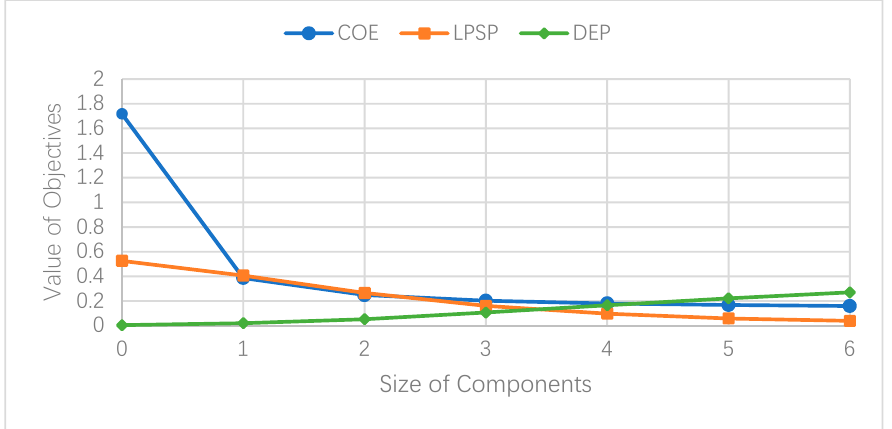
Figure 18. Sensitivity analysis results of WTs.